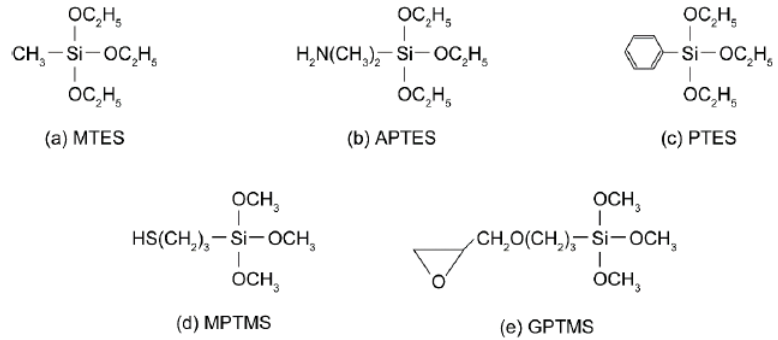
Figure 1. Silicon compounds using modification of FAU-type zeolite membrane in this study. ( a ) Methyl- triethoxysilane (MTES), ( b ) 3-aminopropyltriethoxysilane (APTES), ( c ) phenyltriethoxysilane (PTES), ( d ) 3-mercaptopropyltrimethoxysilane (MPTMS), and ( e ) 3-glycidoxypropyltrimethoxysilane